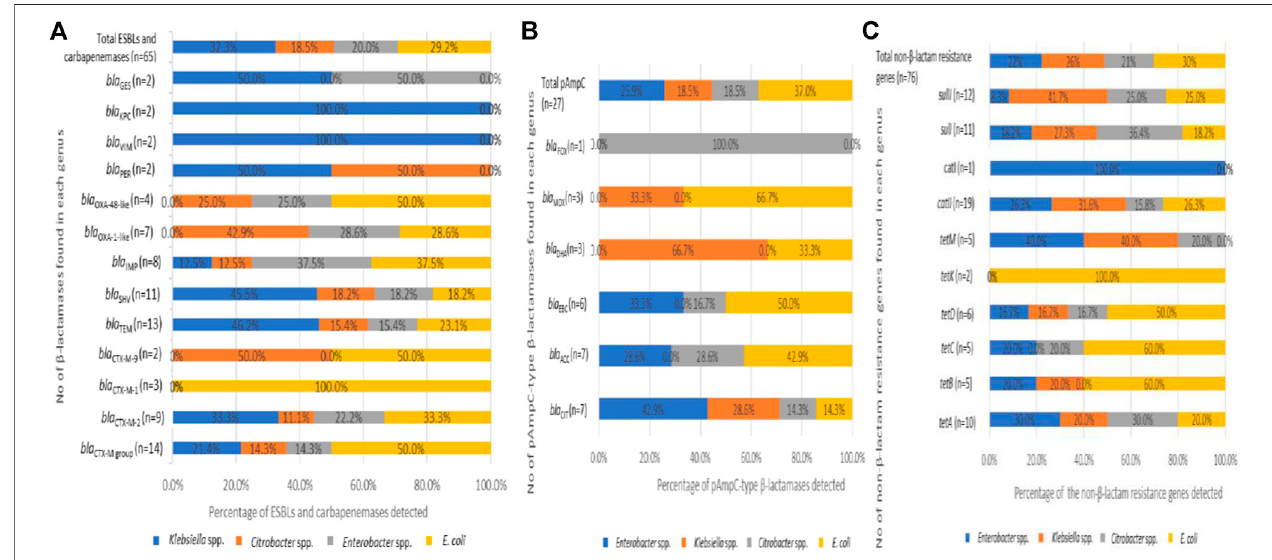
FIGURE 4 | The distribution of extended-spectrum β -lactamases, plasmid-mediated AmpC β -lactamases in the Enterobacteriaceae recovered from the fi nal ef fl uents of WWTPs. (A) Distribution of ESBLs (B) Distribution of pAmpCs and (C) Distribution of non- β -lactam resistance genes which are present in the recovered bacterial